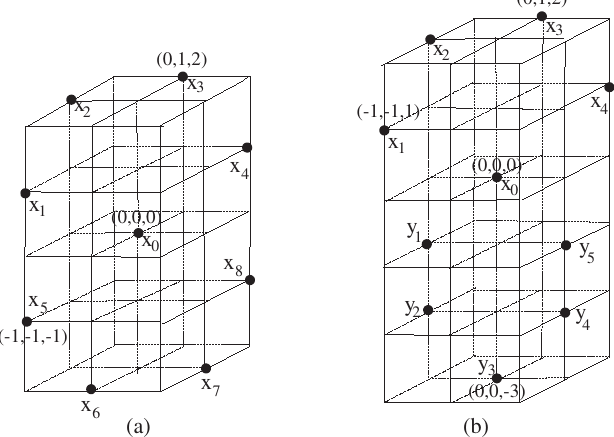
Figure 6. Configuration of digital wedges of two simple closed k -curves, k ∈ { 8,18,26 } , SC 3,5 3,6 ( x ) ∨ SC 3,5 : = ( y i ) i ∈ [ 0,5 ] . ( a ) SC 3,5 . Here, n = 3, the underlying 3-dimensional lattice i i ∈ [ 0,4 ] Z and SC 26 26 18 Z is shown as a dashed grid. The digital wedge generated by the two simple closed 26-curve consisting of 5 points appears as black dots labelled x 0 through x 8 with SC 3,5 ∨ SC 3,6 SC 2,6 ,26 ) = ( SC 3,5 ,26 ) . Here, n = 3, the underlying 3-dimensional lattice is shown as a dashed 8 26 18 grid. The digital wedge generated by both the simple closed 26-curve and the simple closed 18- or 8-curve appears as black dots labelled x 0 through x 4 and y 1 through y 5 with SC 3,5